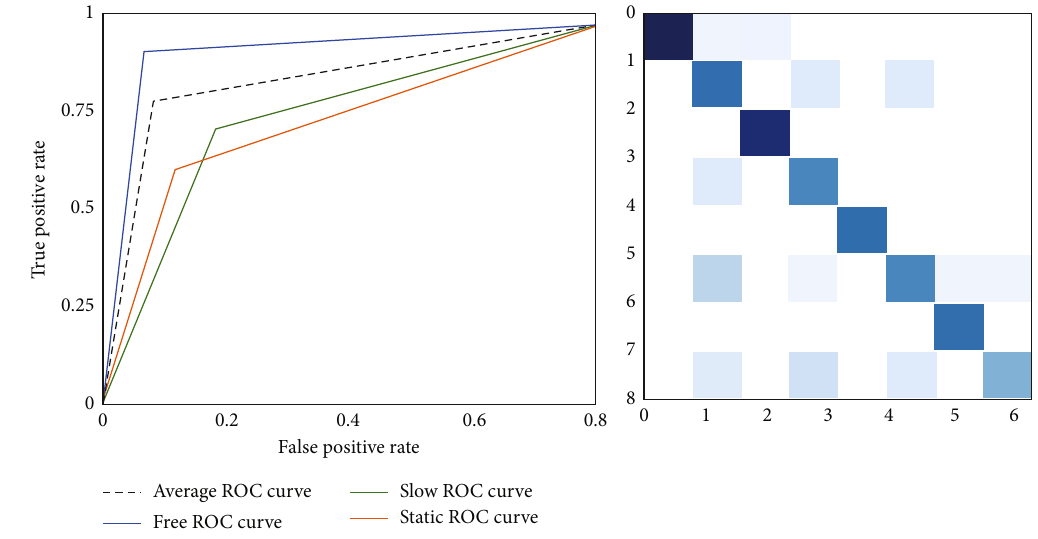
Figure 6: ROC curves and confusion matrix plots for three vehicle modes.